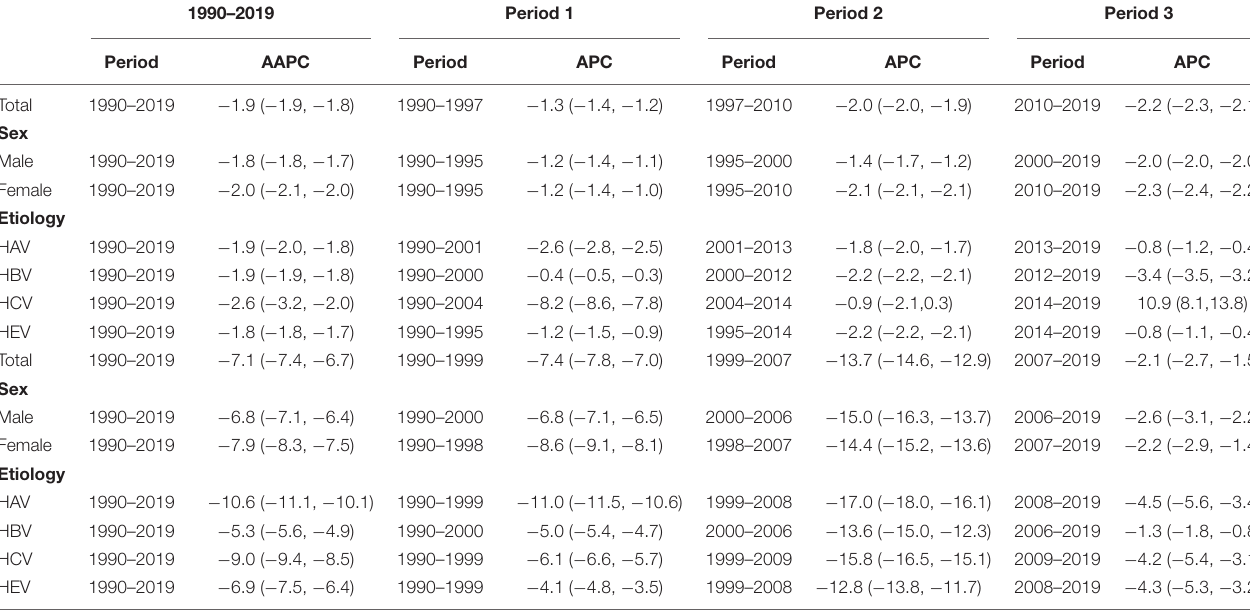
TABLE 2 | Joinpoint regression analysis for ASIR and ASMR of viral hepatitis in China, 1990–2019.